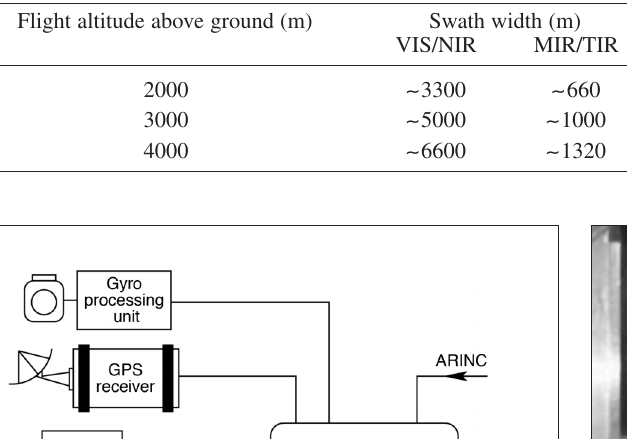
Table IV. ABAS-Swath width and pixel sizes for various flight altitudes above ground. Flight altitude above ground (m)